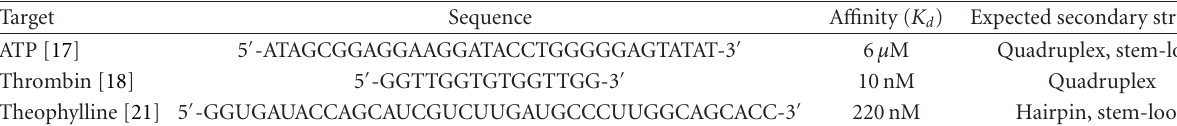
Table 1: Sequences of aptamers used and their a ffi nities for corresponding target.